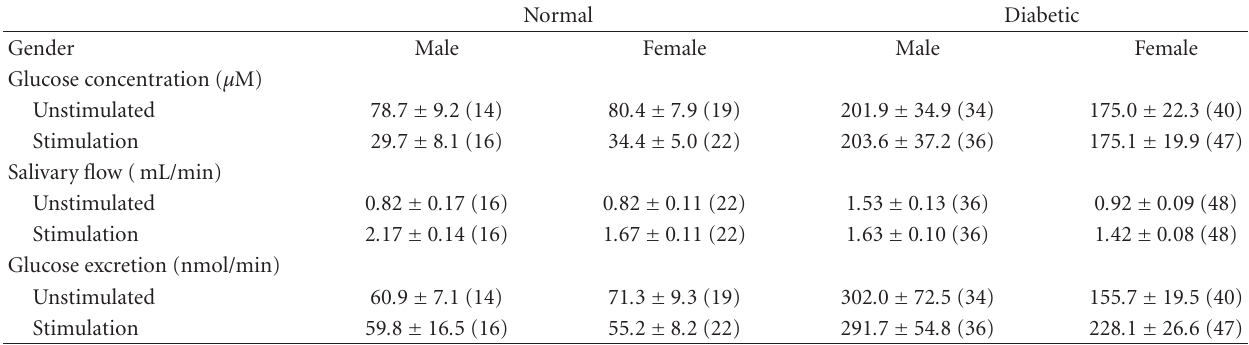
Table 1: Unstimulated and stimulated data in normal and diabetic